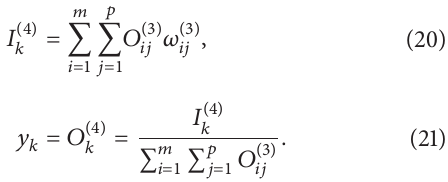
Figure 1: The architecture of